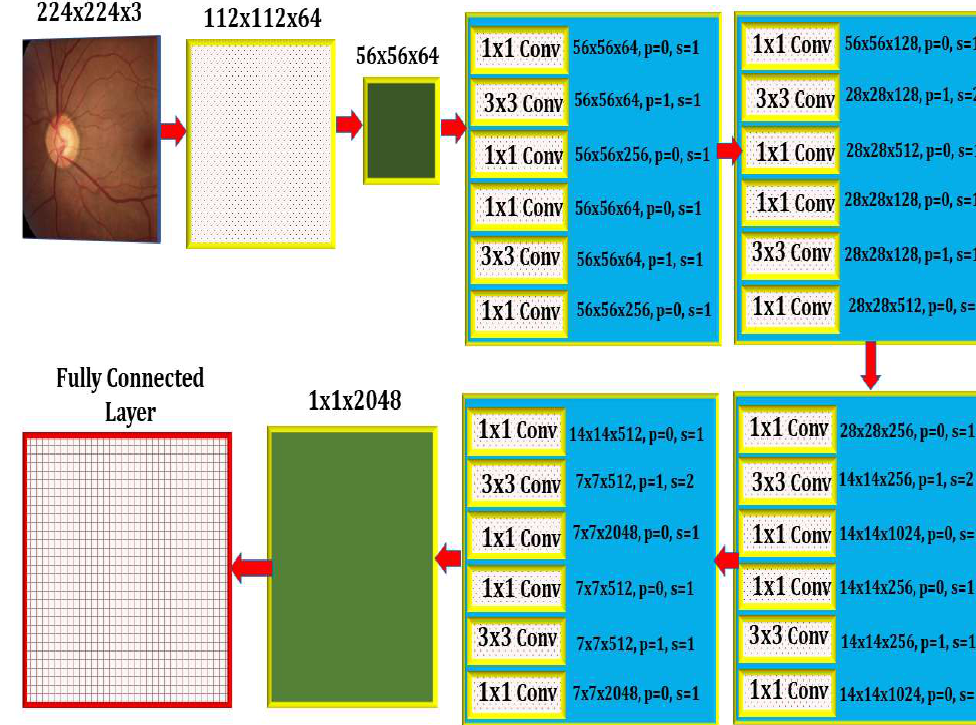
Figure 3. The Internal Architecture of the Proposed Model.